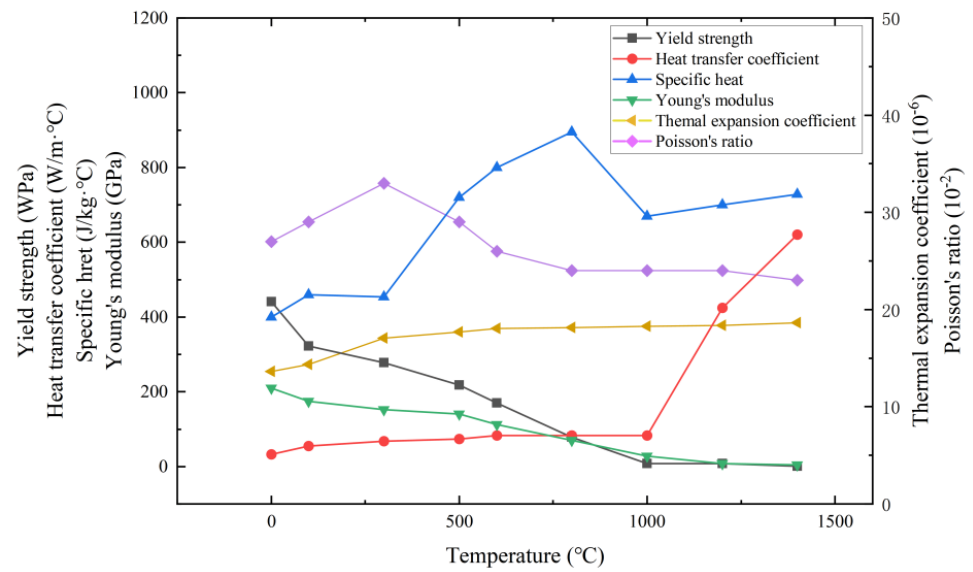
Figure 4. Material properties of 2205 duplex stainless steel with temperature.